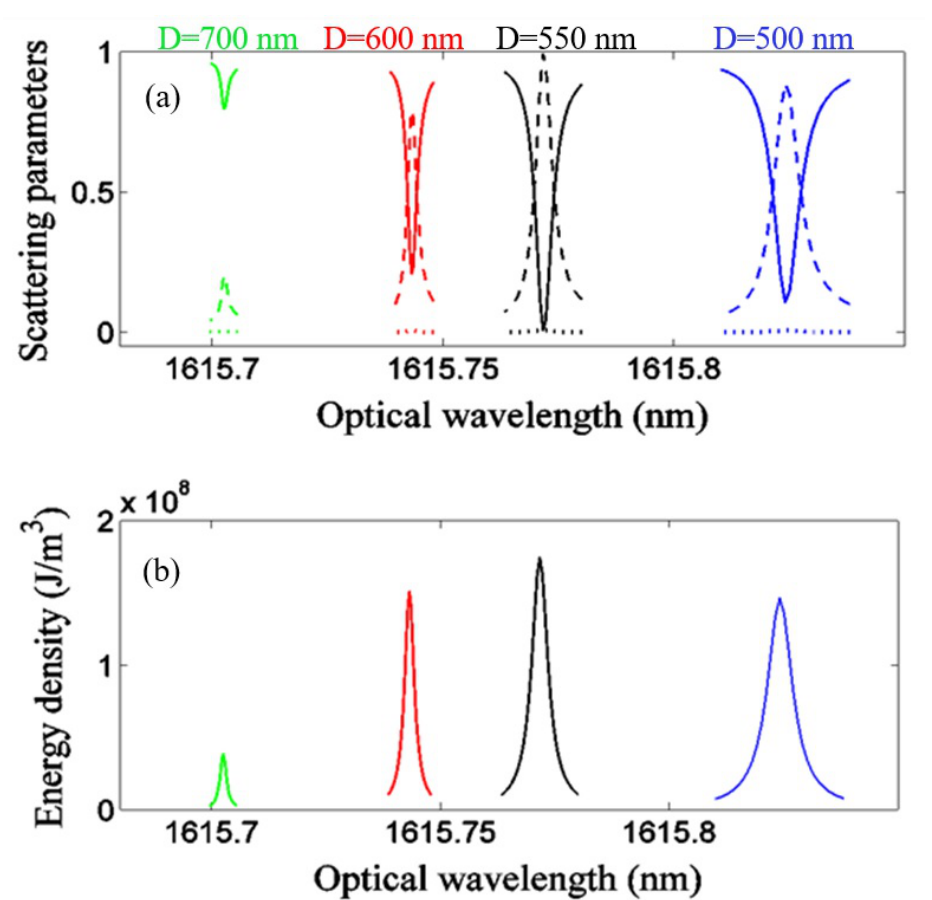
Figure 3. Electromagnetic (e.m.) simulation of the cavity-waveguide system. ( a ) Transmission towards ports 2 or 3 (dotted lines), reflection towards port 1 (full lines) and radiated fraction of the optical power (dashed lines) for λ = 1615 nm in the geometry of Figure 1a. Transmission at port 4 is almost zero. ( b ) Energy density inside the cavity. The colors indicate the distance D between the phoxonic crystal and the optical waveguide while L 0 = − 50